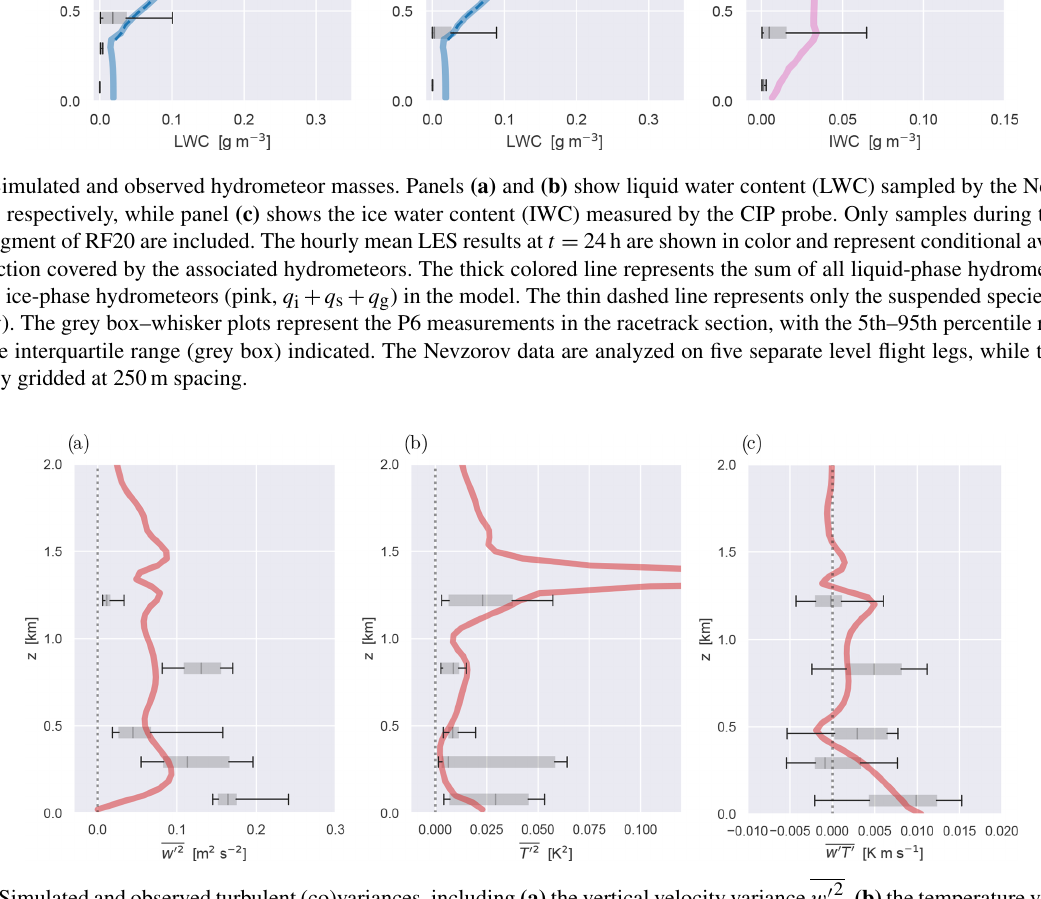
Figure 10. Simulated and observed turbulent (co)variances, including (a) the vertical velocity variance w (cid:48) 2 , (b) the temperature variance T (cid:48) 2 , and (c) the associated temperature flux w (cid:48) T (cid:48) . Similar to Fig. 9 the box–whisker plots again indicate P6 measurements, this time showing nose boom data during the five level flight sections on the southern racetrack. The mean LES profile at t = 24h is shown in